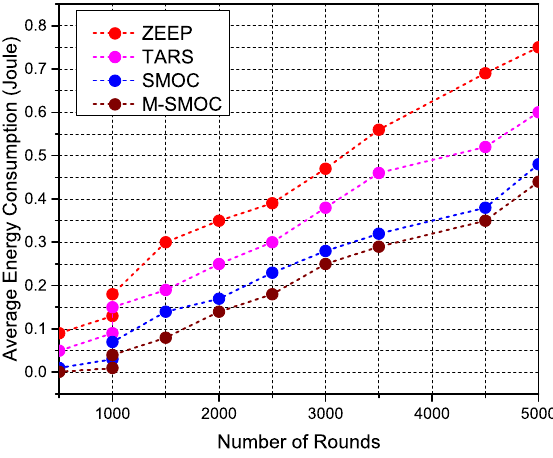
Figure 7. Comparison of the average energy consumption with respect to the number of rounds.